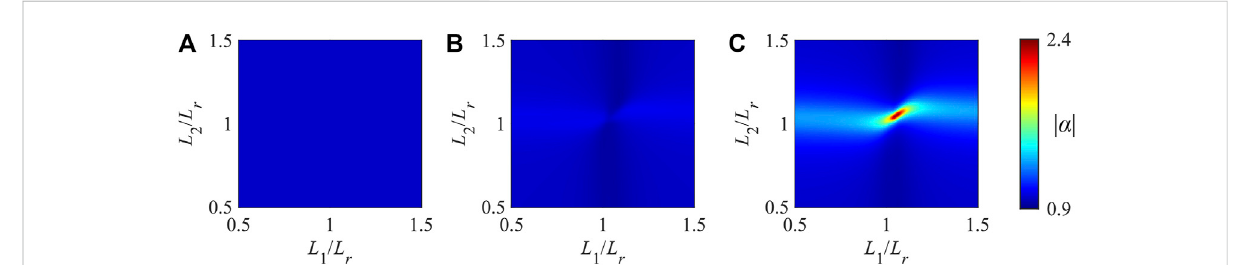
FIGURE 2 | α | varying with inductances L